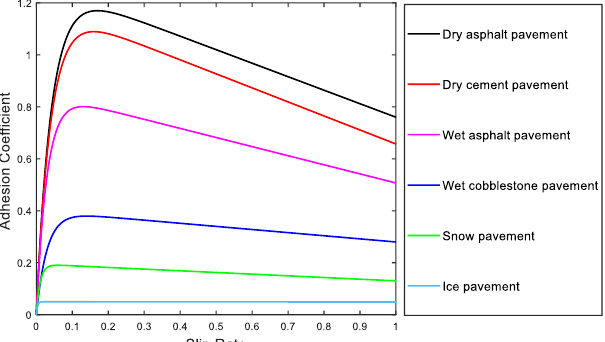
− λ relationship Figure 9. -   relationship curve. Figure 9. µ